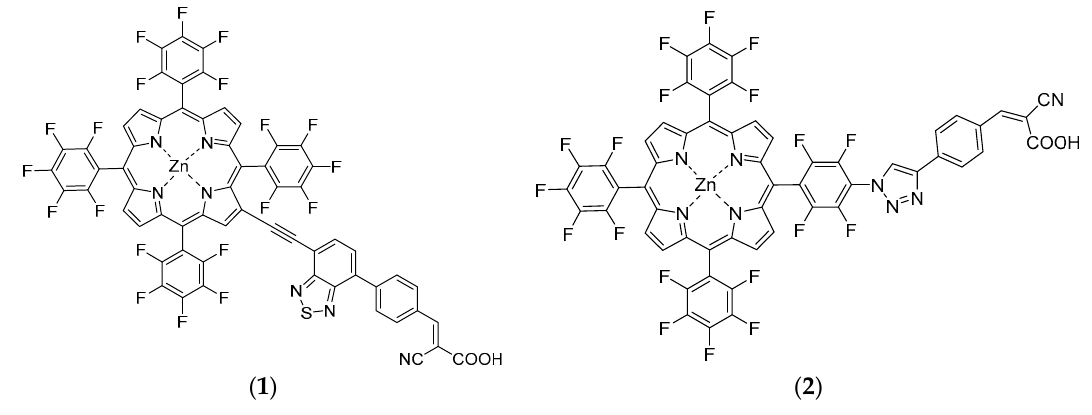
Figure 1. Zn II porphyrins investigated in this work.